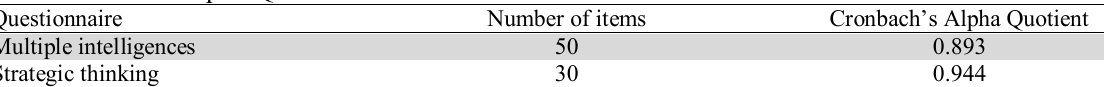
The Cronbach’s Alpha Quotient Questionnaire